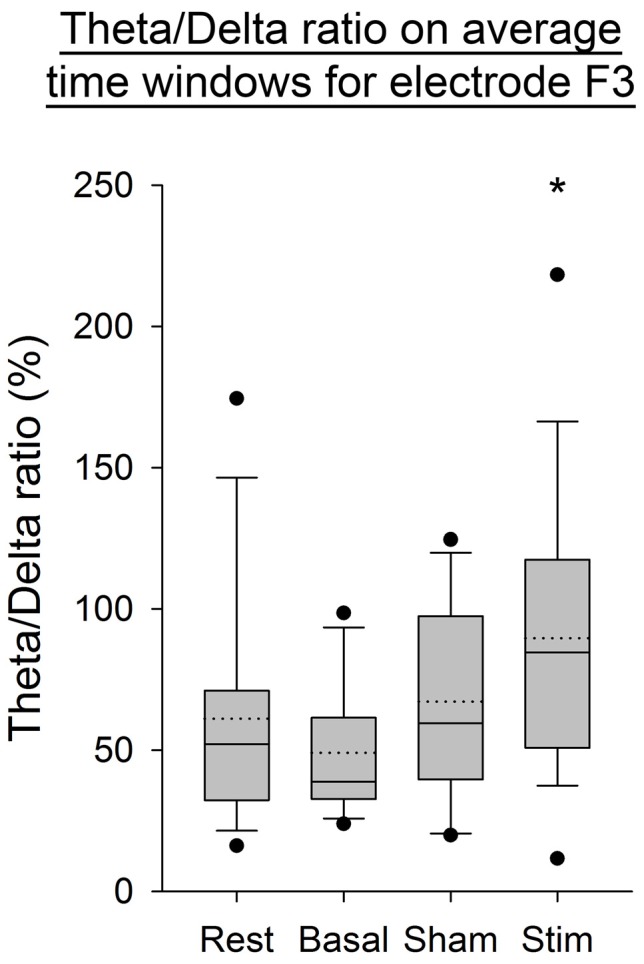
EEG Theta/Delta ratio for the F3 electrode, from the average of power spectral density (PSD) over time windows for all subjects per condition. The boxes correspond to the 25–75 percentiles, the continuous lines are the median values, the dotted lines are the mean values and the whiskers represent the 10 and 90 percentiles. The dots are the outlying values. Note the increase for the active stimulation condition. The Theta/Delta ratio is expressed in percent (%), *p < 0.05 as compared to the three other conditions.